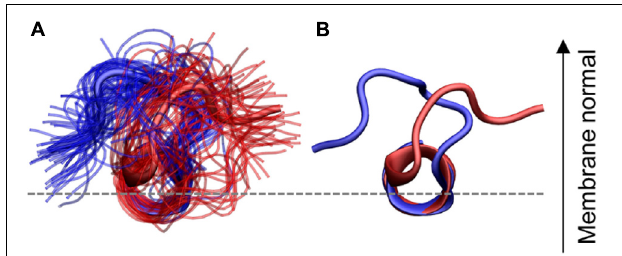
FIGURE 10 | N-terminal loop orientations, structures with loop orientation 1 (O1) and 2 (O2) are shown in blue and red, respectively. (A) Ensemble of structures from the two largest clusters (B) central structure from each of the two orientations. The C-terminal region is hidden for